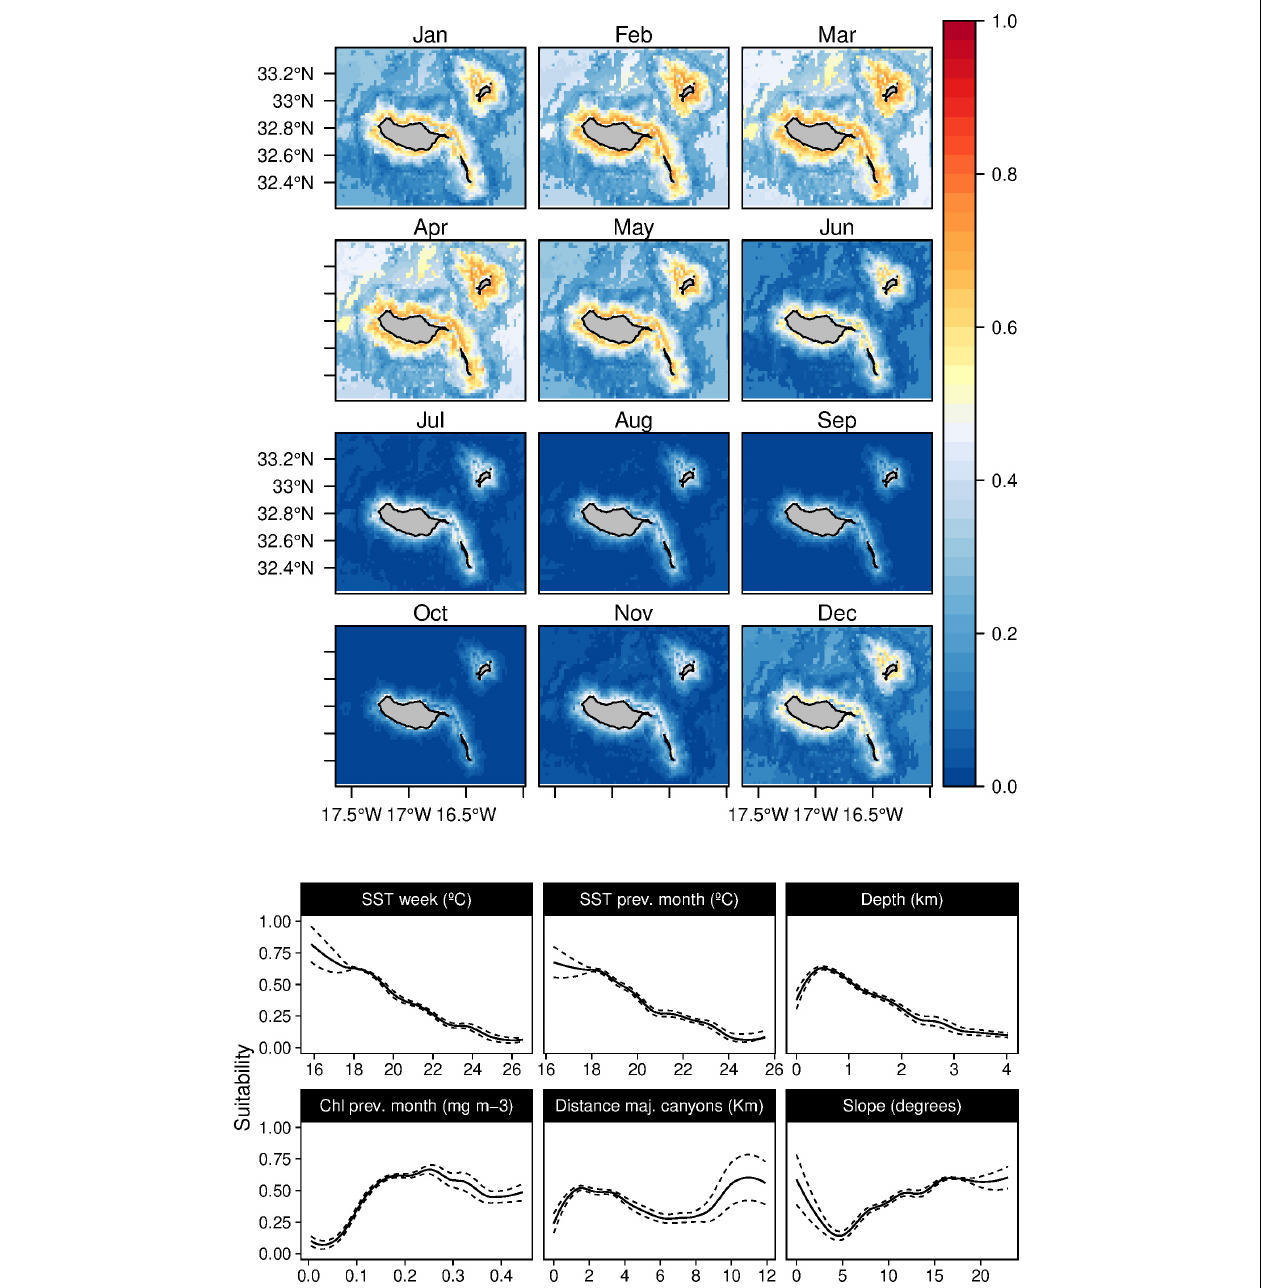
FIGURE 8 | Mean monthly suitability maps (above) and smoothed response curves with standard deviation (below) in the Madeira archipelago for Delphinus delphis for the “8-days” models. In the maps, red represents more suitable and blue less suitable. Responses curves are ordered by percent contribution of the environmental